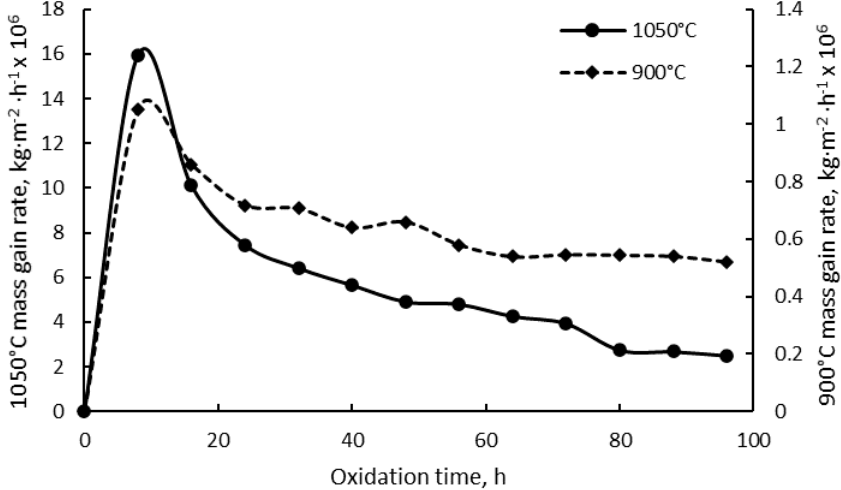
Figure 2. Cumulative mass gain rates of the specimens oxidized at 900 °C and 1050 °C.